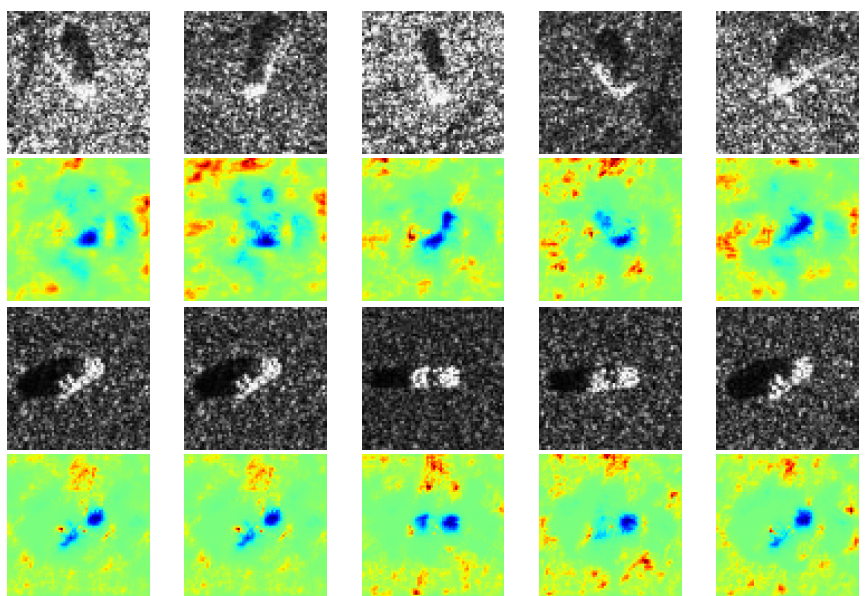
Figure 9. Negative contributions are targets while positive contributions are speckles. The first and third rows are SAR images of two classes: BRDM_2 and SN_C71. The second and fourth rows are the corresponding heatmaps generated by our method.